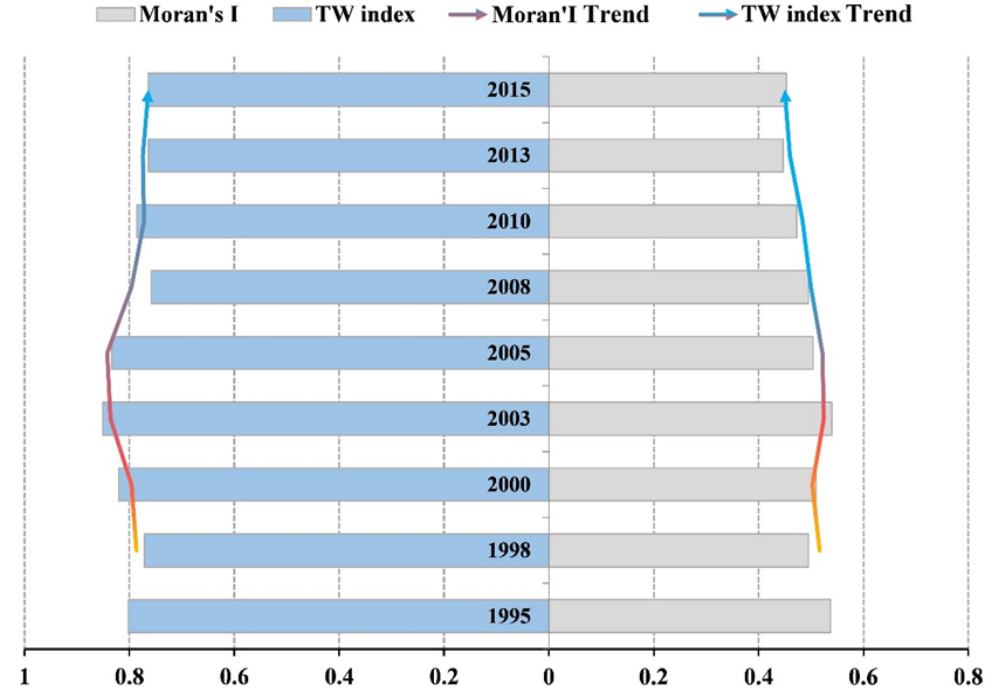
Figure 8. The Tsui–Wang index (TW) and Moran’s I in the YRD region (1995–2015).